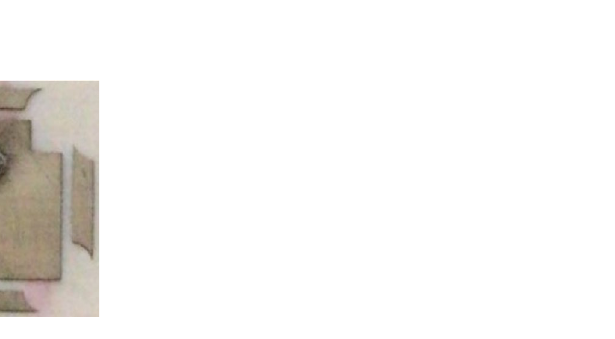
Figure 8. Optimized antenna-1; simulated (left) fabricated (right). Unit is